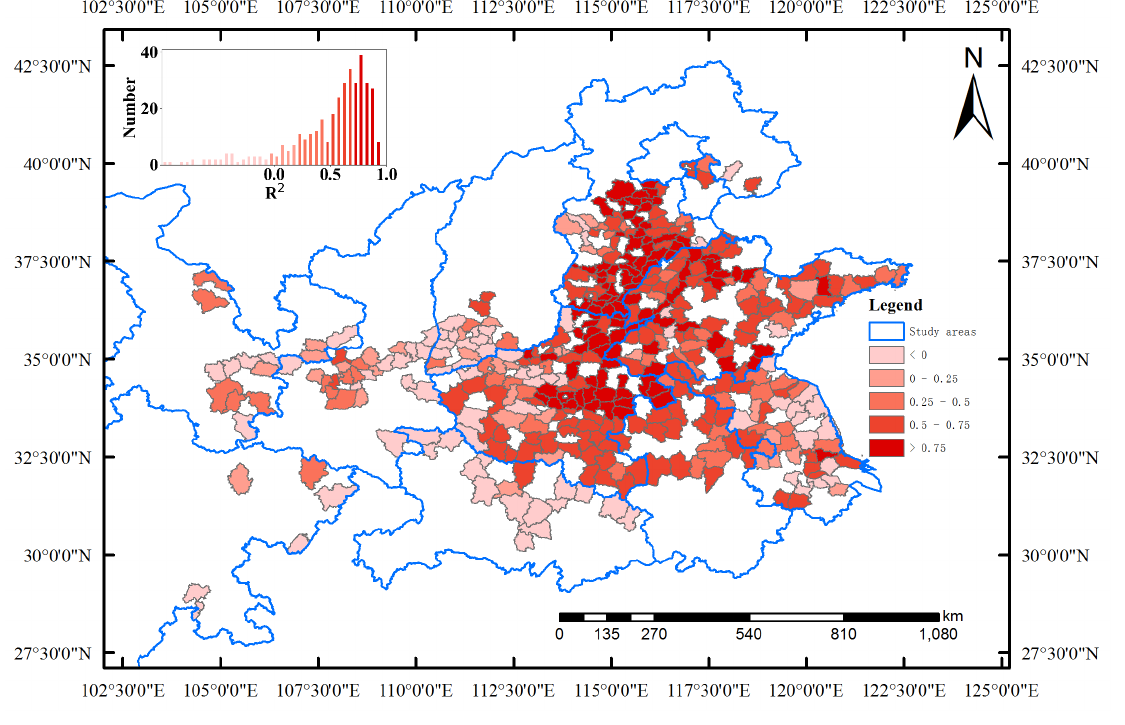
Figure 5. Spatial distribution of the Coefficient Of Determination (R 2 ) calculated from the predicted yields of all the years for each county. The inset panel in the upper left is the histogram of R 2 .